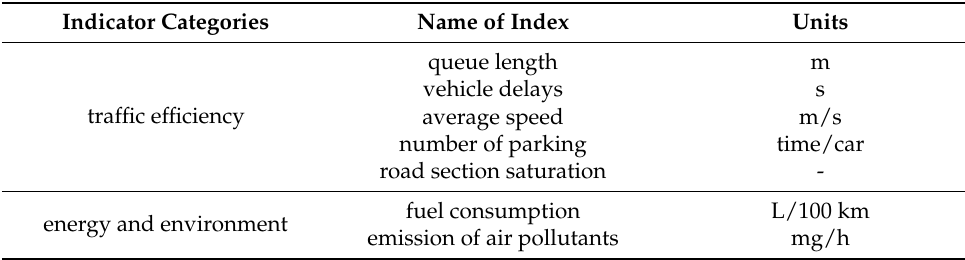
Table 3. Analysis indicators